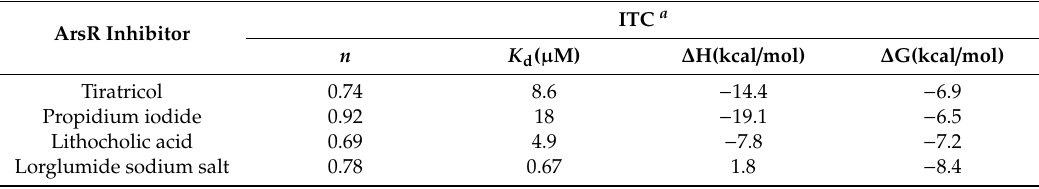
Table 2. Thermodynamic analysis of the interaction between ArsR and its inhibitors by ITC. ArsR Inhibitor